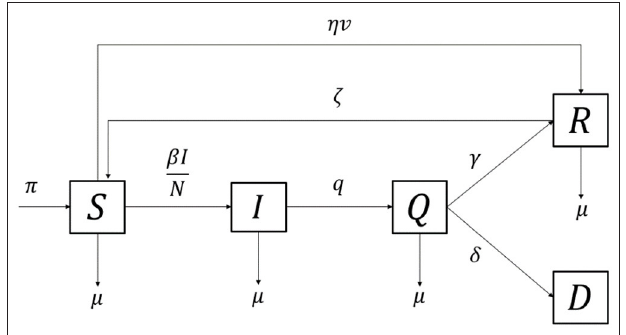
FIGURE 1 | Flow chart of SIQRD model with vaccination and reinfection